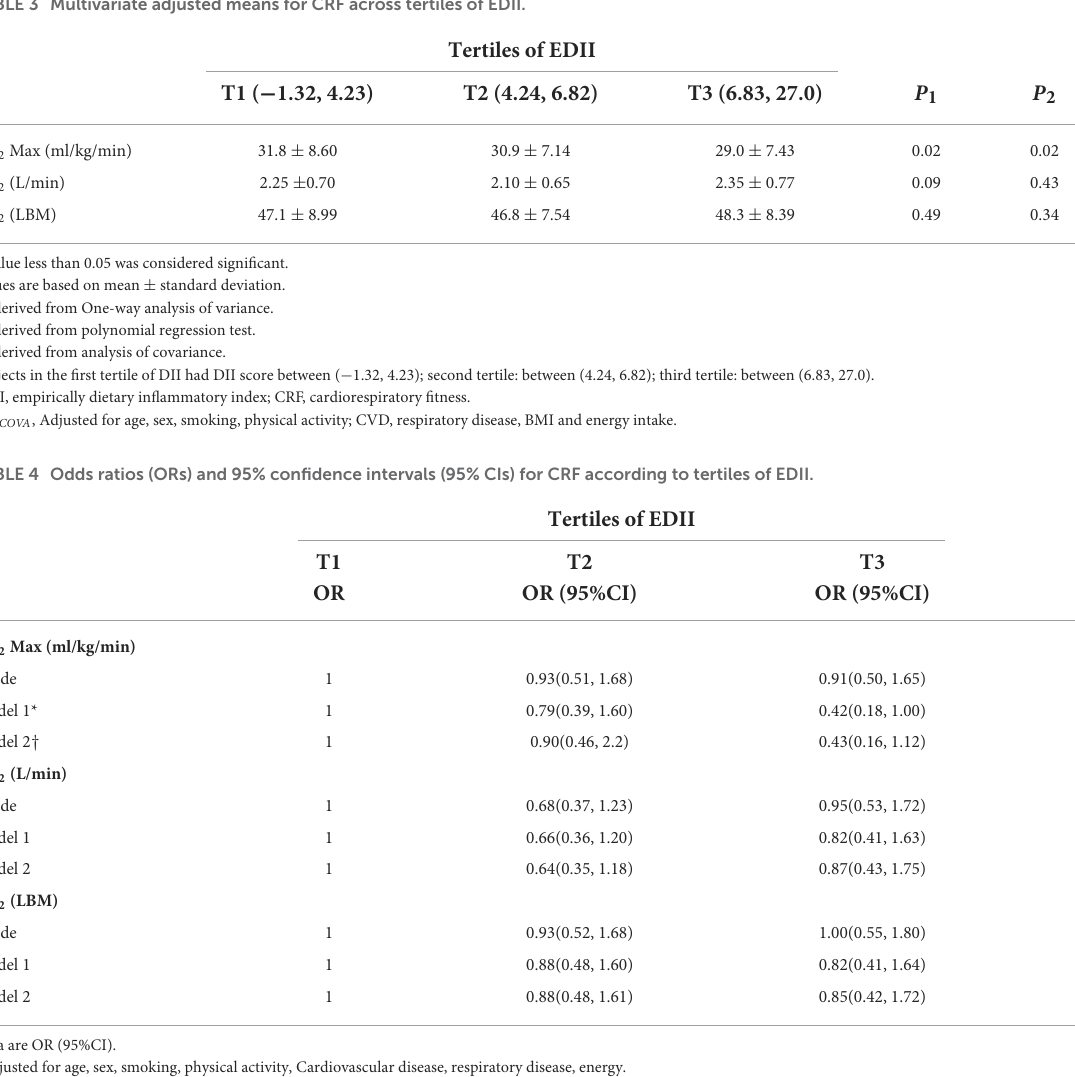
TABLE 3 Multivariate adjusted means for CRF across tertiles of EDII.